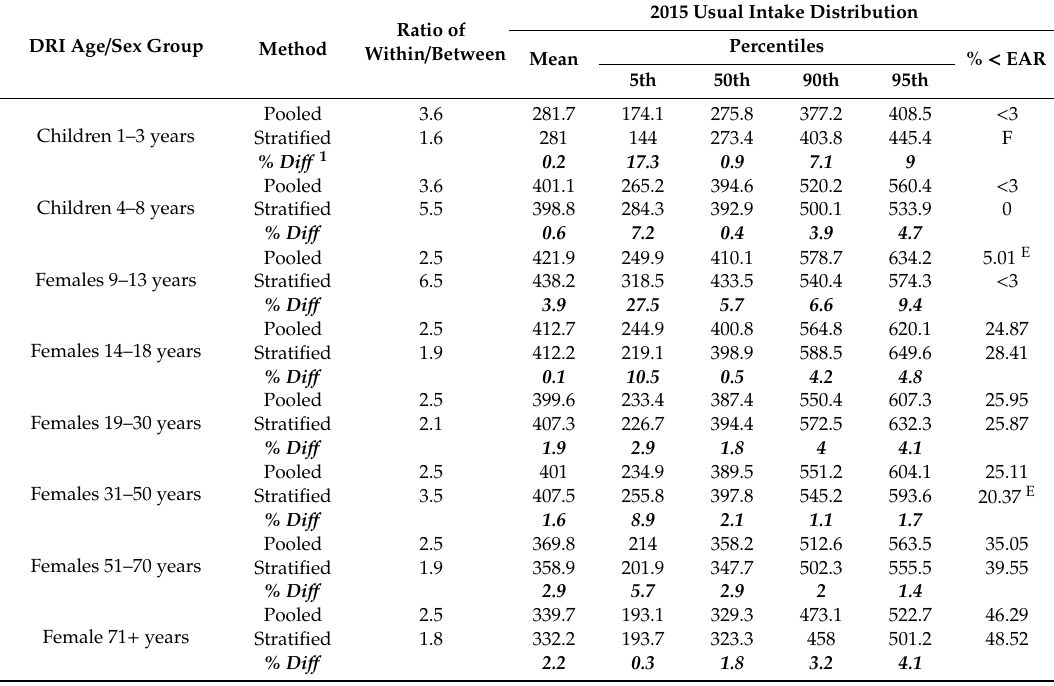
Figure 2. Comparison of estimates of usual intake distribution of DFE ( µ g / day) between pooled versus the stratified approach for ( a ) females 9–13 years old; and ( b ) females 19–30 years old. Data Sources: Statistics Canada, 2004 and 2015 Canadian Community Health Survey—Nutrition Share files. Table 1. Comparison of distributional estimates of dietary folate equivalents ( µ g / day) by the National Academies Dietary Reference Intakes (DRI) groups—National Cancer Institute (NCI) Method—Amount